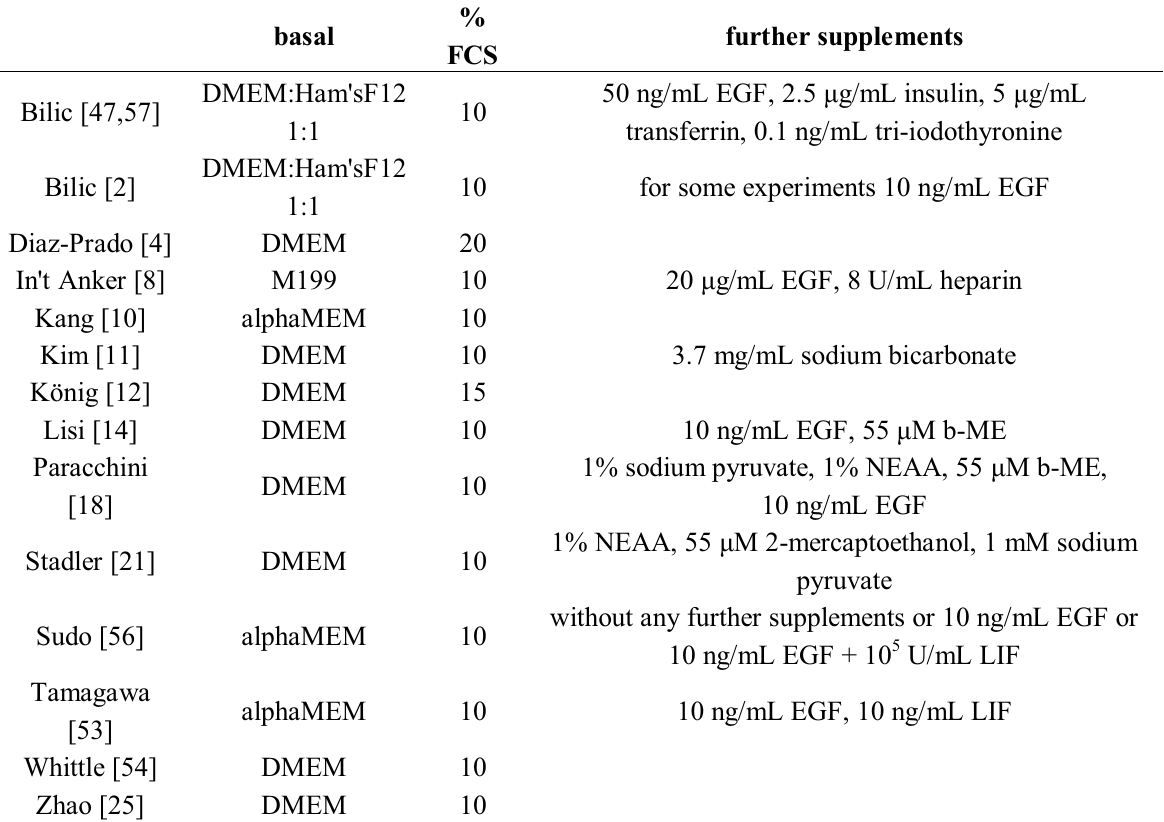
Table 1. Media used for expansion of human amnion/amniotic mesenchymal stromal cells (hAMSC); Abbreviations: FCS fetal calf serum, DMEM (cid:39)(cid:88)(cid:79)(cid:69)(cid:72)(cid:70)(cid:70)(cid:82)(cid:182)(cid:86)(cid:3) (cid:80)(cid:82)(cid:71)(cid:76)(cid:73)(cid:76)(cid:72)(cid:71)(cid:3) (cid:40)(cid:68)(cid:74)(cid:79)(cid:72)(cid:86)(cid:182)(cid:86)(cid:3) medium, EGF epidermal growth factor, M199 medium 199, b-ME beta-mercaptoethanol, NEAA nonessential amino acid, LIF leukemia inhibitory factor, MEM minimal essential medium